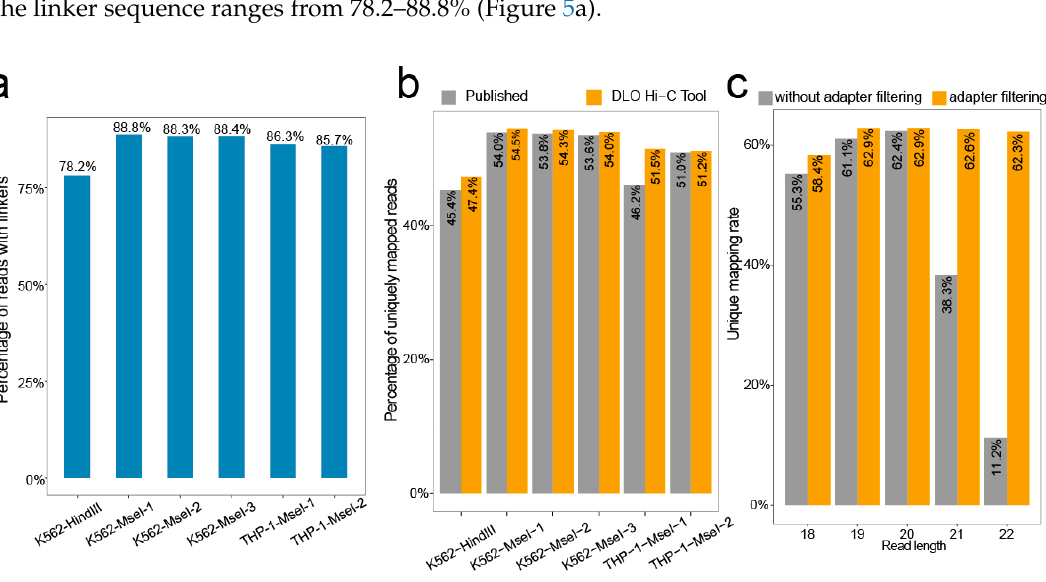
Figure 5. The ratio of linker sequence and unique mapping rate. ( a ) The proportion of reads containing the linker to the raw reads. ( b ) The uniquely mapping rate obtained from the DLO Hi-C Tool without iterative alignment and published results of different samples. ( c ) As the maximum read length increases, the unique mapping rate changes for performing adapter filtering or no adapter filtering. Table 4. Comparison of different strategies.